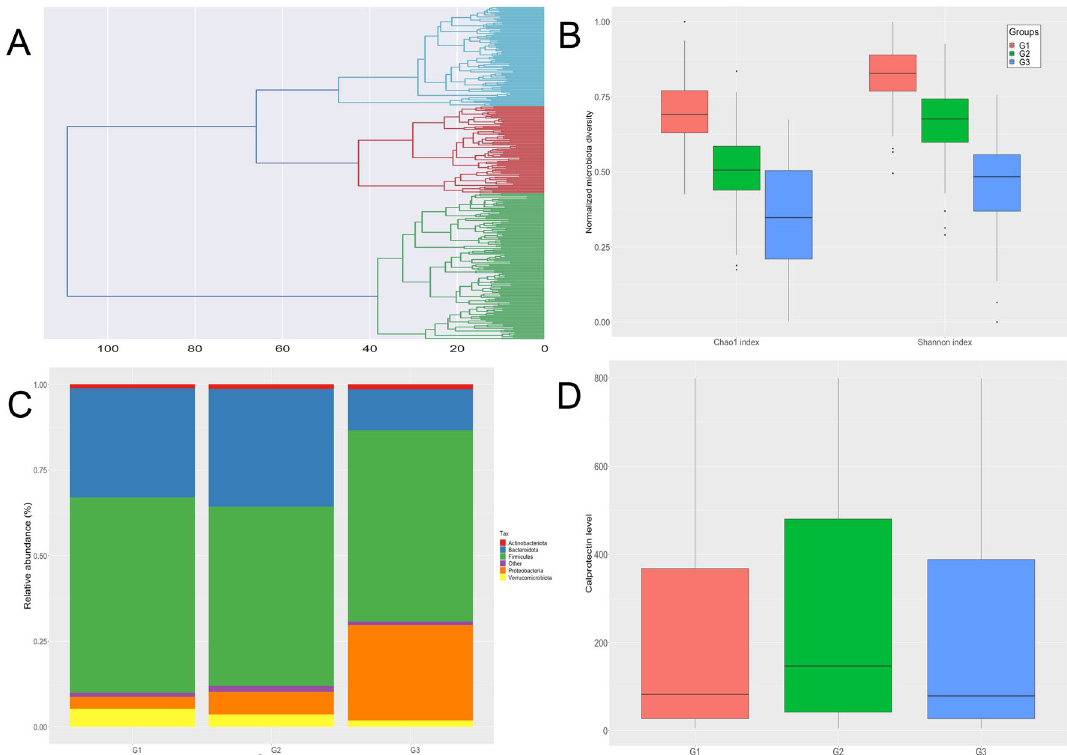
Figure 1. Gut microbiota from 259 CD patients (n = 321 samples). ( A ) Ascending hierarchical classification (AHC) of the 321gut microbiota : three distinct groups (G1, G2, G3) are identified, depicted in blue, red and green, respectively. ( B ) A decreasing Shannon index and Chao1 index is observed from G1 to G3 (p = 2.6e−15 and 4.02e−13 respectively). ( C ) Global composition of gut microbiota at the phyla level in G1, G2 and G3. ( D ) Association between the three groups of gut microbiota G1, G2 and G3 and Calprotectin levels in CD patients: Calprotectin levels are not significantly different between G1, G2 and G3, despite differences in degree of